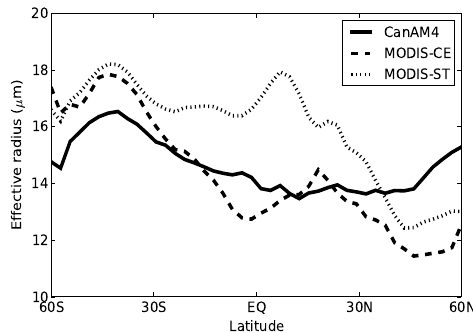
Fig.7. ZonalmeancloudtopeffectiveradiusinJJAfromCCCmaCanAM4,MODIS-CEandMODIS-ST. Fig. 7. Zonal mean cloud top effective radius in JJA from CCCma CanAM4, MODIS-CE and